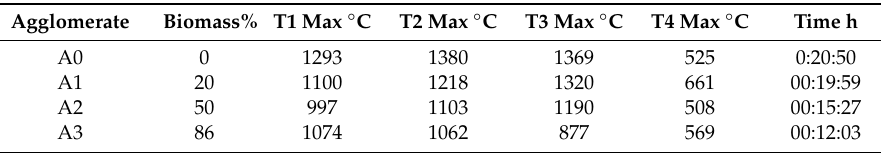
Table 8. Reached temperatures and sintering times.